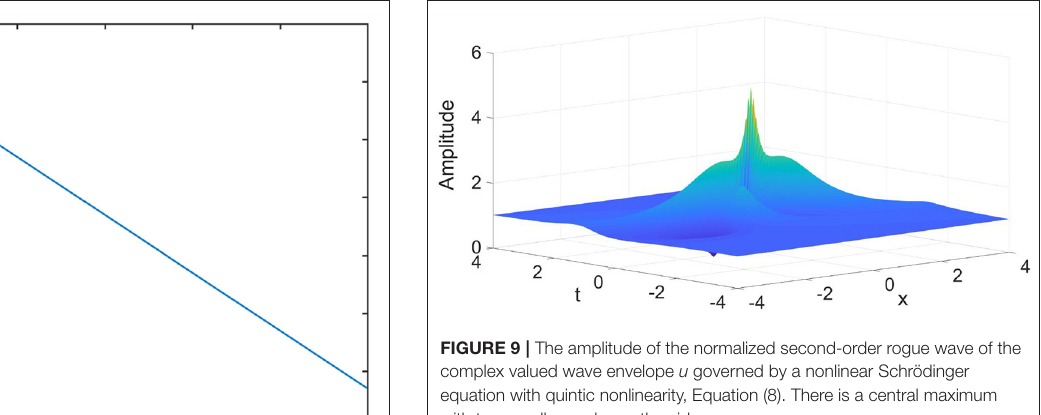
FIGURE 7 | An empirical linear relation between the real parts of the poles at the turning points and parameter b . FIGURE 8 | The amplitude of the normalized first-order rogue wave of the complex valued wave envelope u governed by a nonlinear Schrödinger equation with quintic nonlinearity, Equation (8). The profile resembles a classical Peregrine soliton.